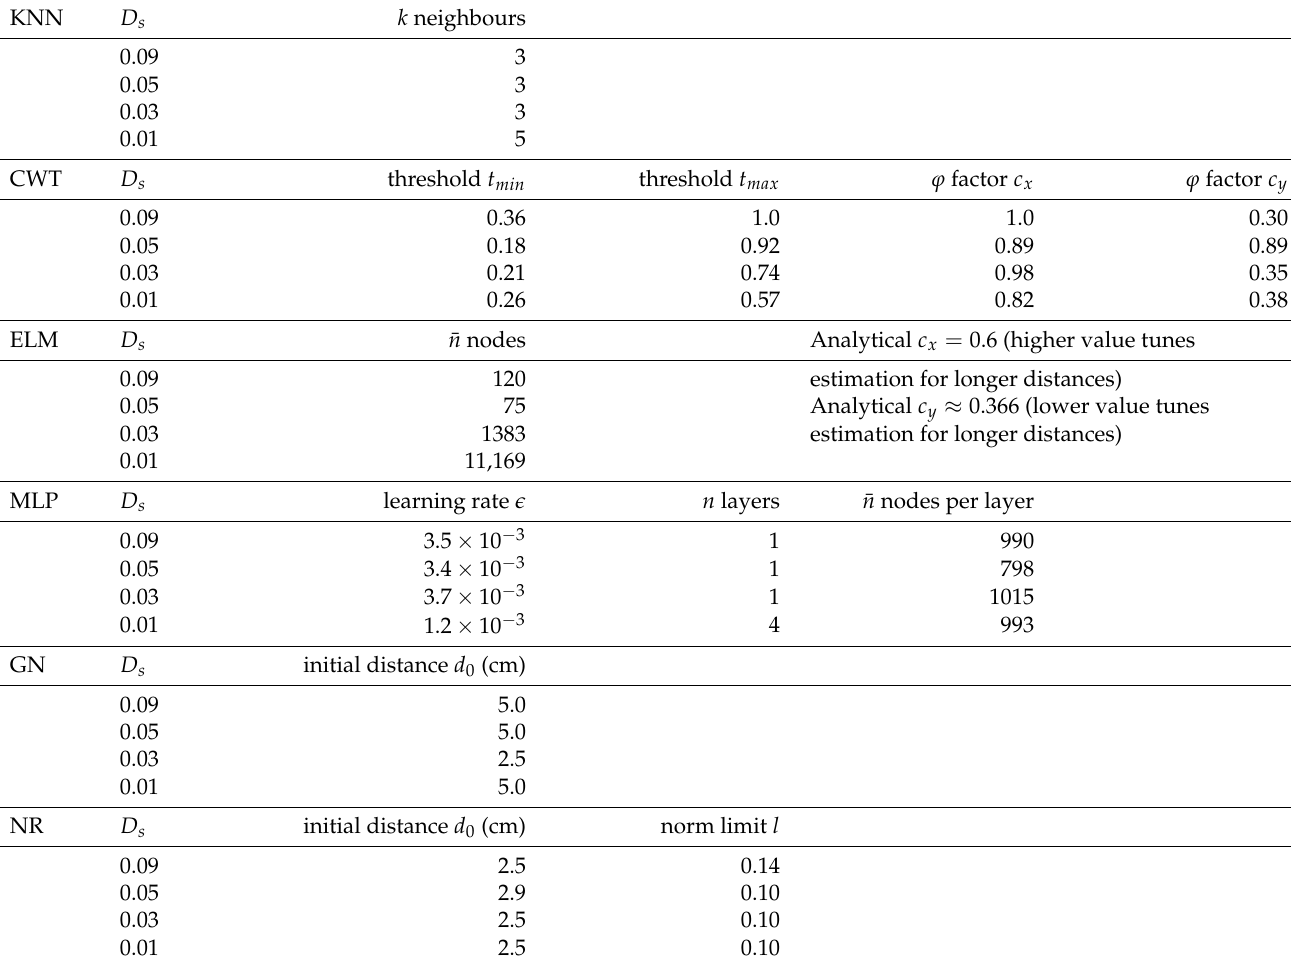
Table A1. All hyperparameter values for the first analysis optimised using the training set. This analysis varied the minimum distance D s between source states in the training and optimisation sets to show how the amount of training and optimisation data influences the dipole localisation algorithms’ performance. The (x + y) sensor configuration at